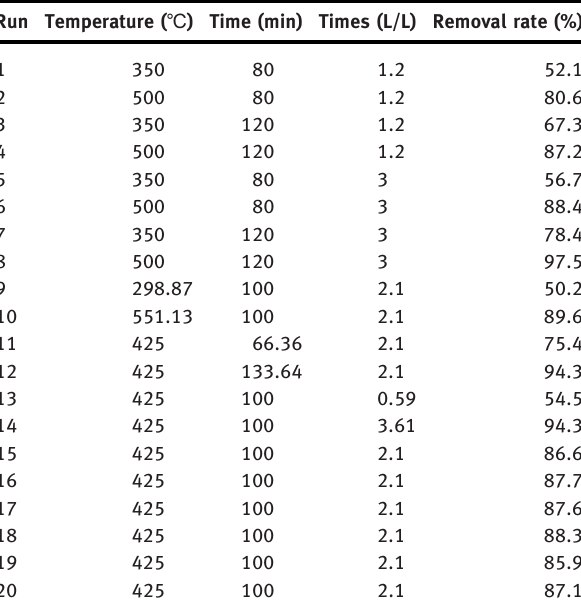
Table 4: Experimental design matrix and result of dechlorination rate of CuCl residue by microwave roasting (Times=Actual consump- tion of oxygen/Theoretical oxygen demand).